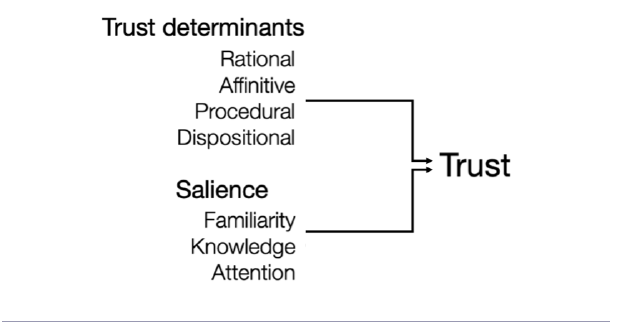
Fig. 1 . Trust in a water utility is a function of judgments about the utility, the utility’s regulatory system, and personal propensity to trust, and the salience of the